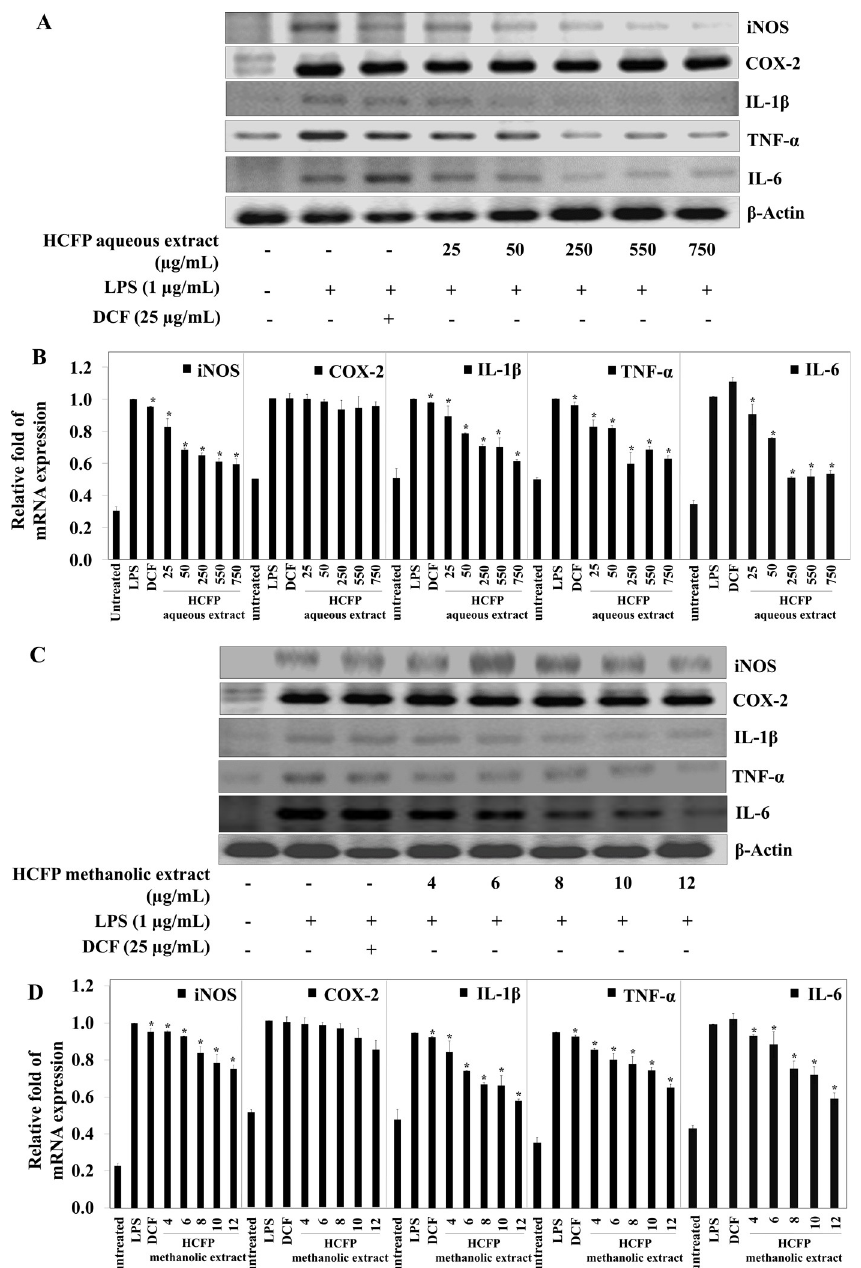
Fig 2. Effect of aqueous and methanolic extracts of HCFP on mRNA expression of iNOS, COX-2, IL-1 β , TNF- α , and IL-6 in LPS-stimulated RAW264.7 cells. The cells were pre-treated with indicated concentrations of aqueous and methanolic extracts for 2 h and then stimulated with LPS (1 μ g/mL) for 6 h. The mRNA expression levels of aqueous extract-treated (A) and methanolic extract-treated (C) cells were determined by reverse transcription-PCR. Bar graphs showed the relative fold of mRNA expression of aqueous extract-treated (B) and methanolic extract-treated (D) cells, � p < 0.05 compared with the LPS group. (Fig 2C and 2D) extracts. COX-2 protein level was not significantly decreased for pre-incuba- tion with both HCFP aqueous (50–750 μ g/mL) (Fig 3A and 3C) and methanolic (4–12 μ g/mL) (Fig 3B and 3D) extracts. The above results suggest that inhibition of NO and PGE